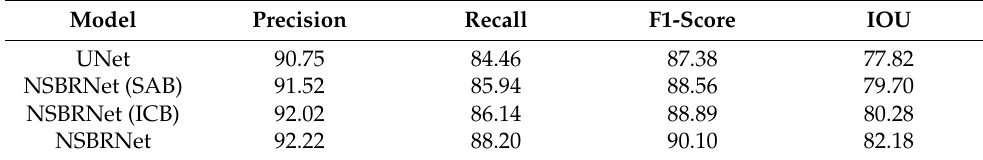
Figure 13. Influence of each model on the performance of NSB recognition. ( a ) FRGB; ( b ) ground truth; ( c ) UNet; ( d ) NSBRNet (SAB); ( e ) NSBRNet (ICB); ( f ) NSBRNet. Green frames are locations where the differences between model recognized and the ground truth are larger. Table 4. Performance of each model in the dataset.